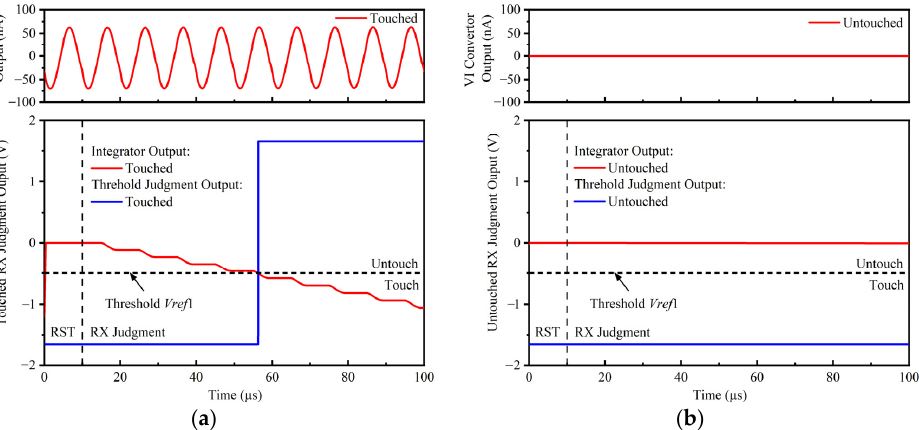
Figure 12. The time-domain waveform of the RX judgment module in the proposed cross-correlation AFE circuit. ( a ) Touched RX judgment output; ( b ) untouched RX judgment output.